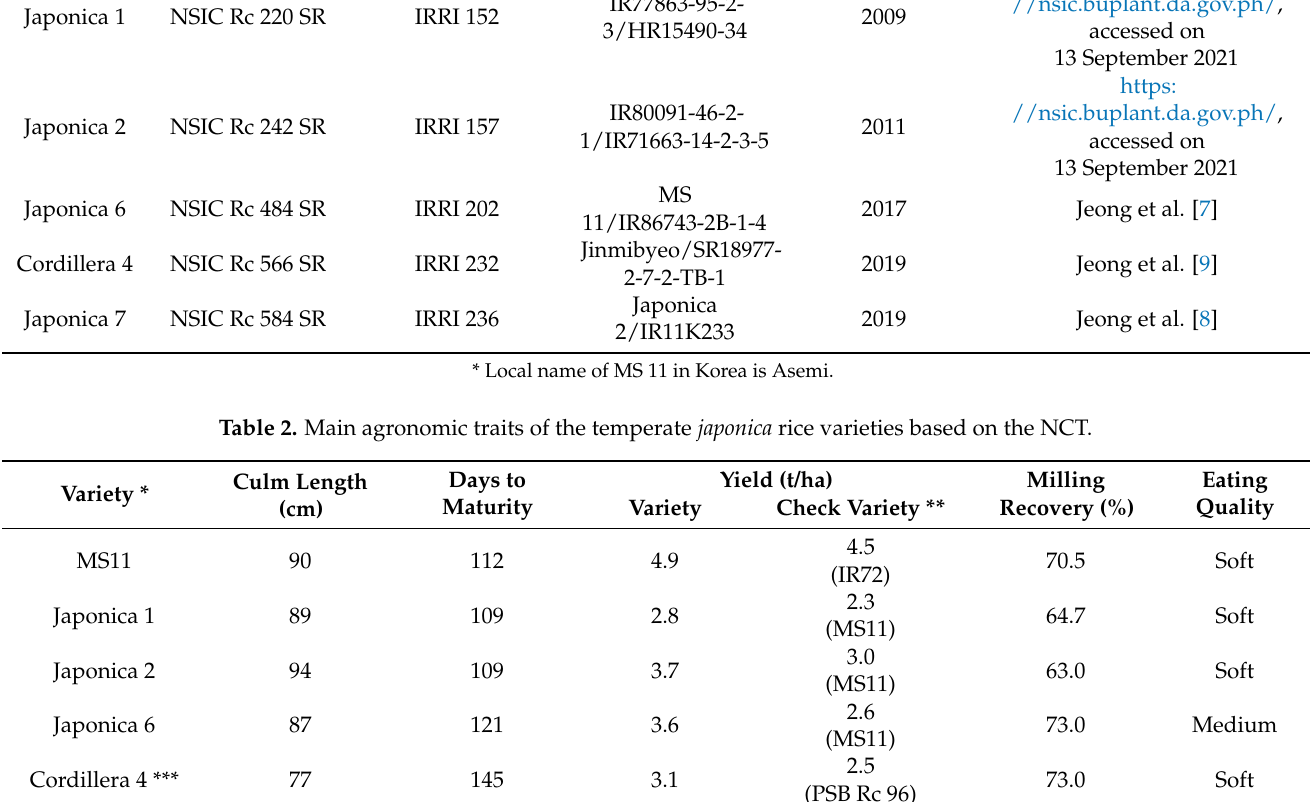
Table 3. Responses to major biotic stresses of the temperate japonica rice varieties based on the NCT.